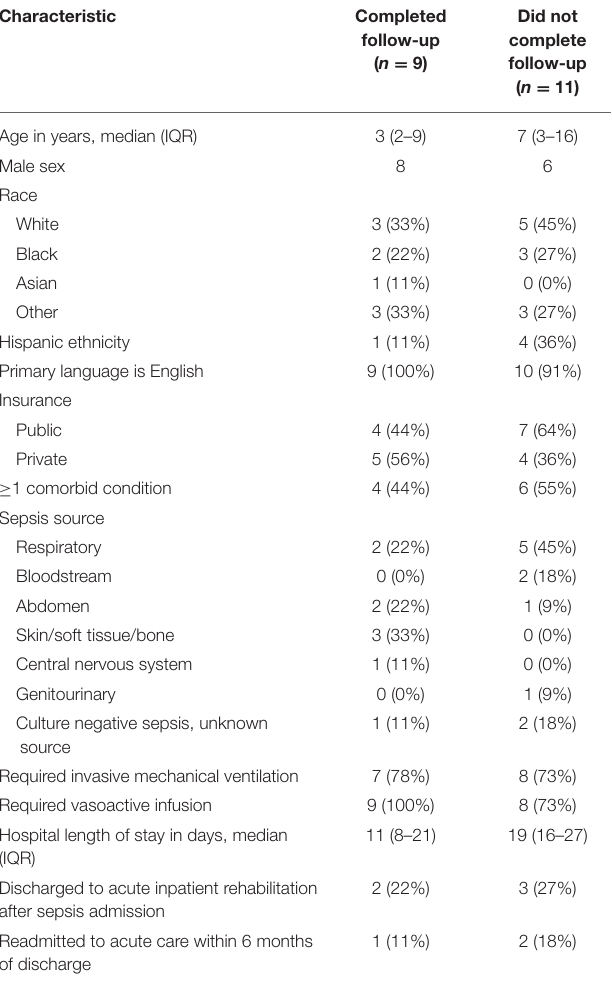
TABLE 1 | Characteristics of patients identified for potential sepsis follow-up. Characteristic n = 80